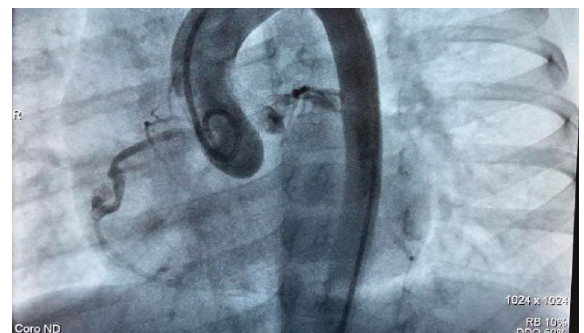
Figure 2: Cardiac catheterization: Aneurysm in the right coronary artery, with an image of intracoronary thrombus.